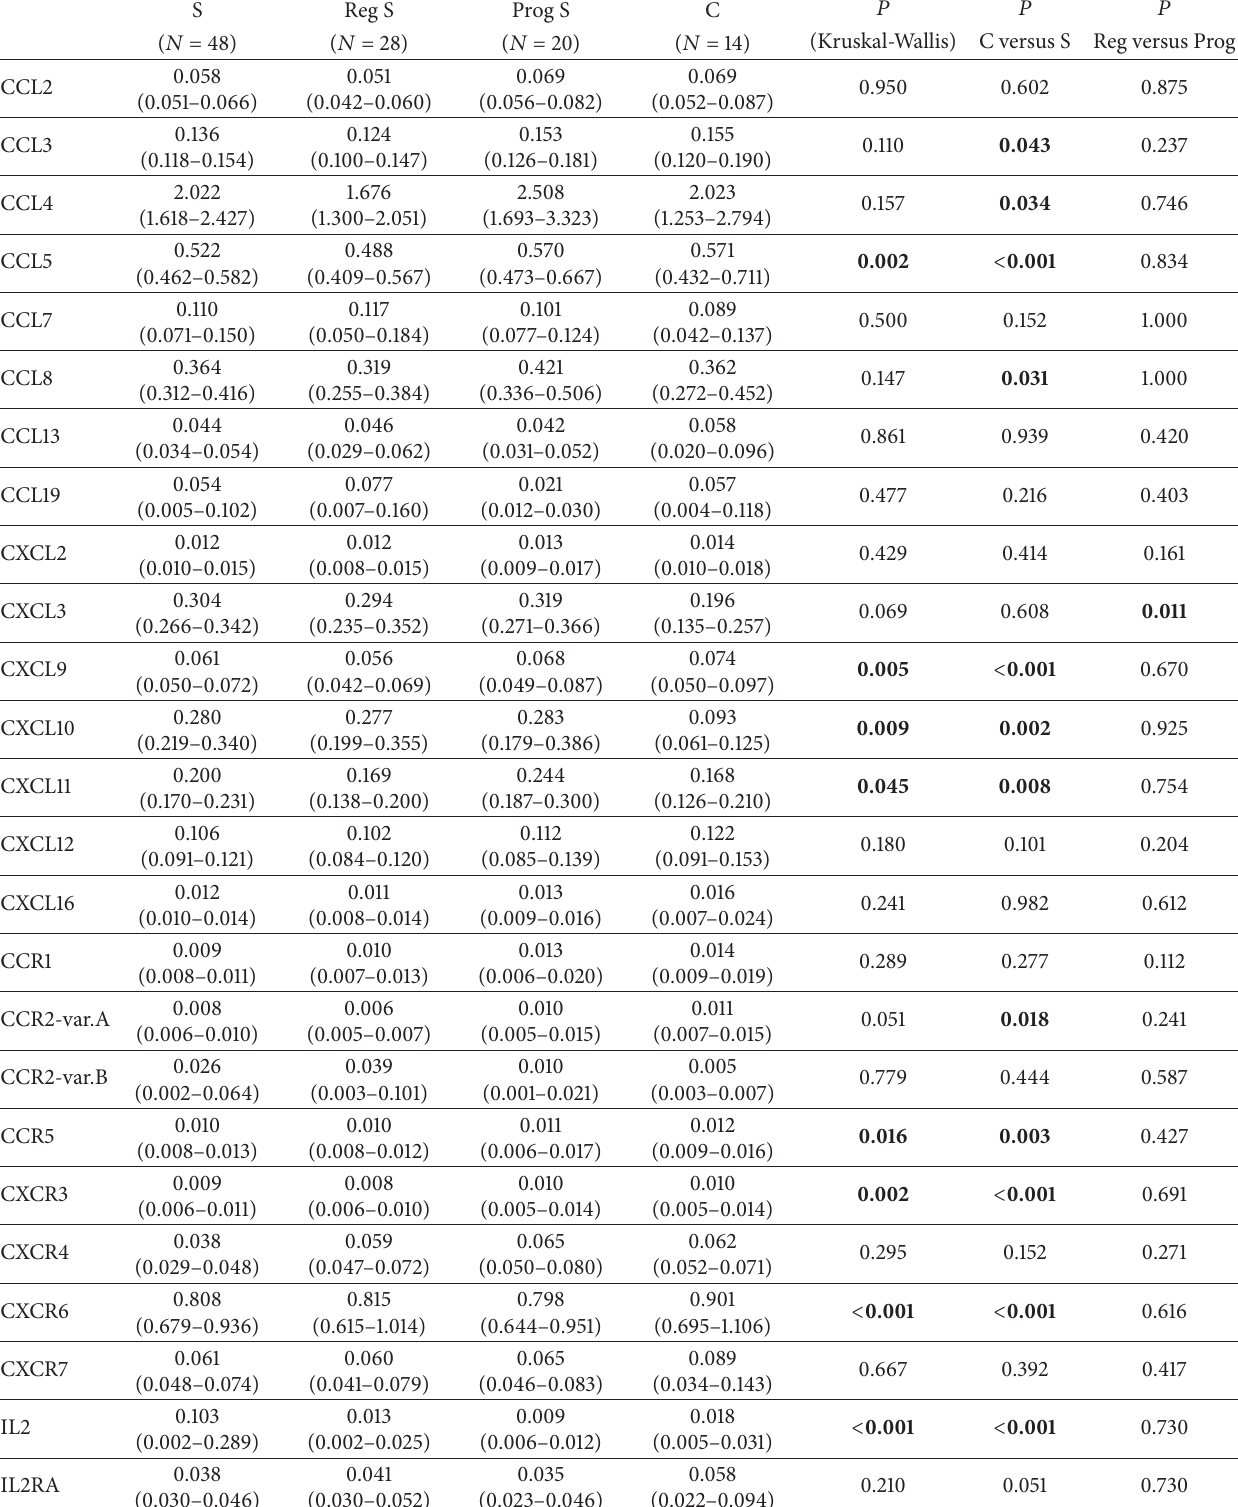
Table 3: Comparison of mRNA expression profiles of studied cytokines, chemokines, chemokine receptors, and T-bet between sarcoidosis (S) patients, subdivided according to the outcome after 2-year follow-up (Reg: regression; Prog: progression), and control subjects (C). All the data are presented as Mean Expression Level (95% confidence interval). Results are expressed relative to levels of a housekeeping gene PSMB2. 𝑁 : number of patients. Bold font indicates significant 𝑃